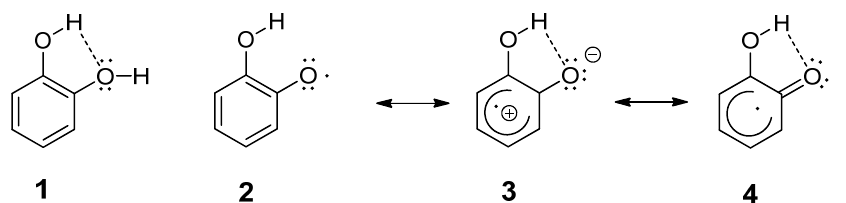
Figure 6. It is postulated that the increased stabilization of the semiquinone radical 2 , compared to that of the parent 1 , is due to the increase in strength of the intramolecular H-bond induced by dipolar 3’s and keto-enol 4’s contributions to the radical’s structure [29].